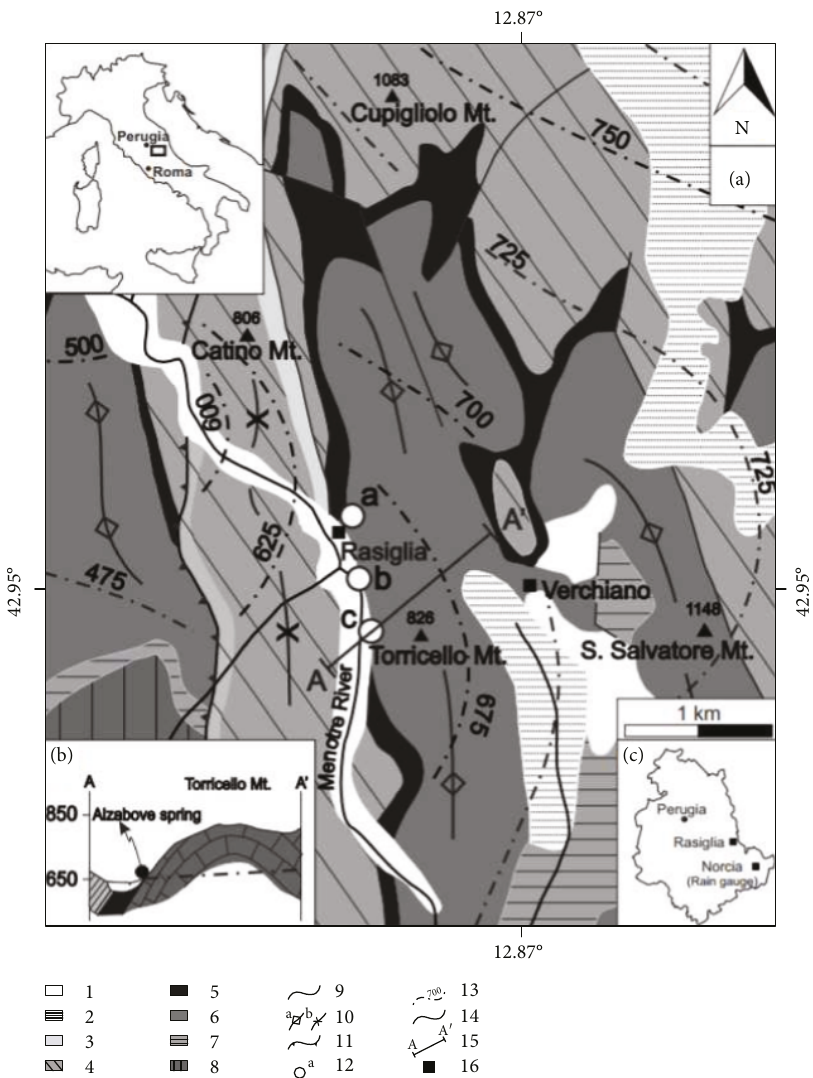
Figure 5: Geological and hydrogeological map (a), section of the Alzabove spring area (b), and rain gauge location (c). Key to the legend: (1) the talus and alluvial deposit complex (Olocene-Pleistocene) has high permeability which constitutes the local aquifer; (2) the lacustrine deposit complex (Olocene-Pliocene) has an aquitard function; (3) terrigenous complexes (marls, scaly clays, and sandstones) (Miocene) have an aquitard function; (4) the Scaglia calcarea complex (Scaglia Rossa and Scaglia Bianca Fm.) (Eocene-Cretaceous) has high permeability and high storing capacity which constitute the regional aquifer; (5) the Marne a fucoidi complex (Lower Cretaceous) has an aquitard function; (6) Maiolica complex (Lower Cretaceous-Jurassic) has high permeability and high storing capacity which constitute the regional aquifer; (7) the calcareous siliceous marly complex (Marne del Sentino-Rosso Ammonitico-Marne ad Aptici Fm.) (Upper Jurassic) has an aquitard function; (8) the Corniola-Calcare Massiccio basal complex (Lower Jurassic) has high permeability and high storing capacity which constitute the regional aquifer; (9) fault; (10) folds: (a) anticline and (b) syncline; (11) thrust; (12) springs: (a) Capo Vena, (b) Verchiano, and (c) Alzabove; (13) groundwater level: the numbers indicate the water above sea level; (14) river; (15) section trace; (16)